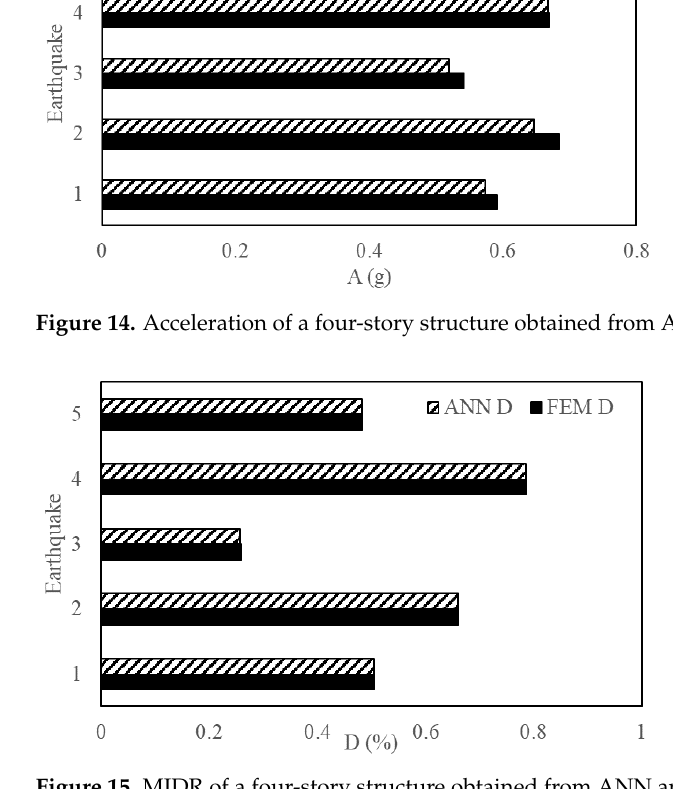
Figure 15. MIDR of a four-story structure obtained from ANN and NLTHA for five EQs. Similarly, the ANN model is also tested on a three-story mass irregularity structure. The earthquakes, this time, consisted of design-based EQs (DBE) and maximum considered EQs (MCE) to achieve meaningful results and to compare them with the results obtained from other conventional methods. Table 4 lists the characteristics of these EQs. Figure 16 shows the design spectrum of these EQs.